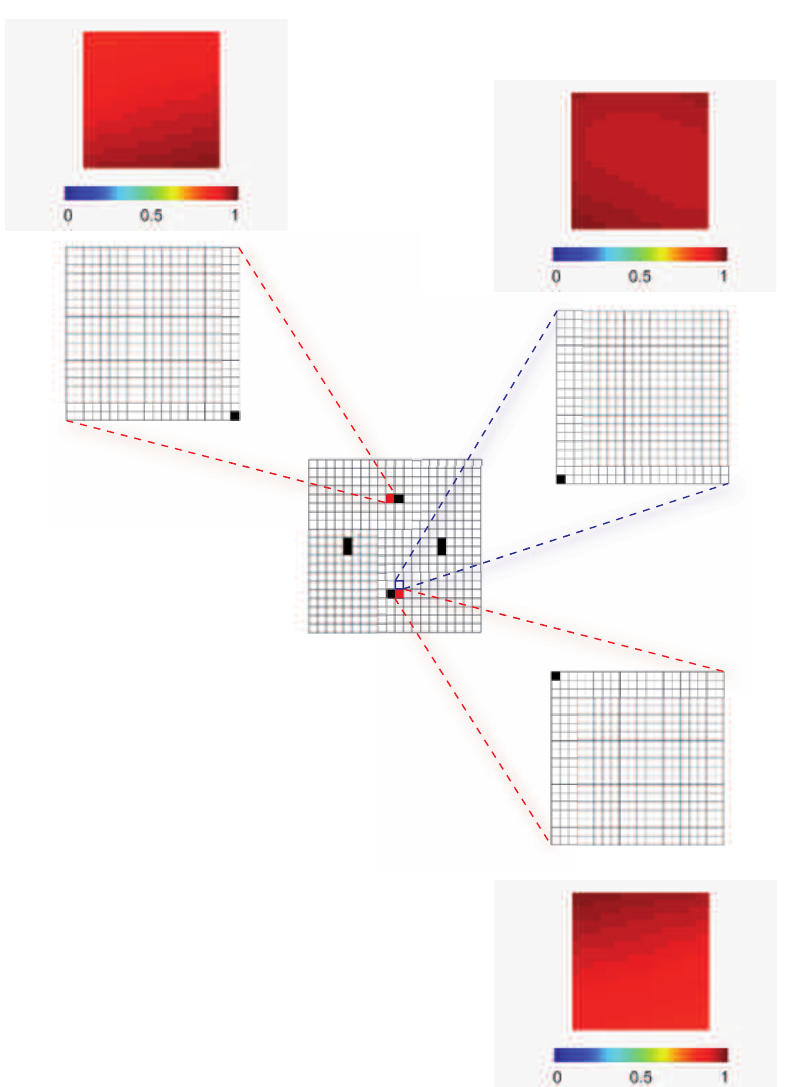
Figure 3. Plate problem, two-scale analysis: optimal sensor placement and mesoscale objective functions ψ m , corresponding to N M = 8 and N m =